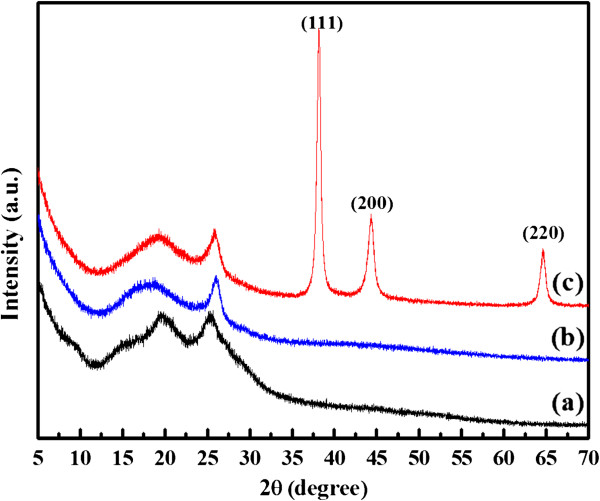
XRD patterns. Curves (a) PANI, (b) PANI(H2PtCl6·6H2O), and (c) PANI(HAuCl4·4H2O).